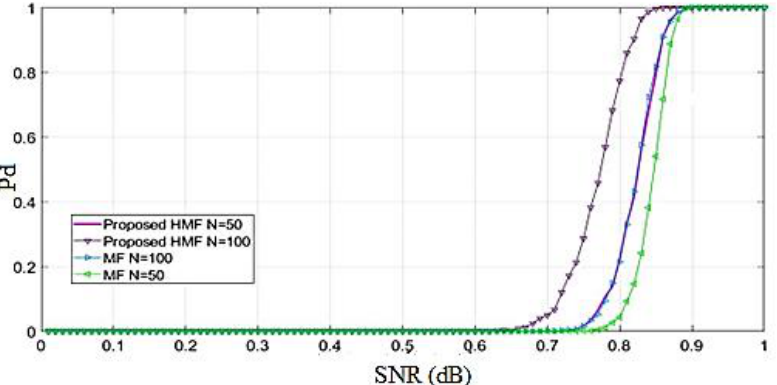
Figure 5. Performance of Pd and SNR for HMF and MF, considering number of samples = 50 and 100 in the Rician Channel.